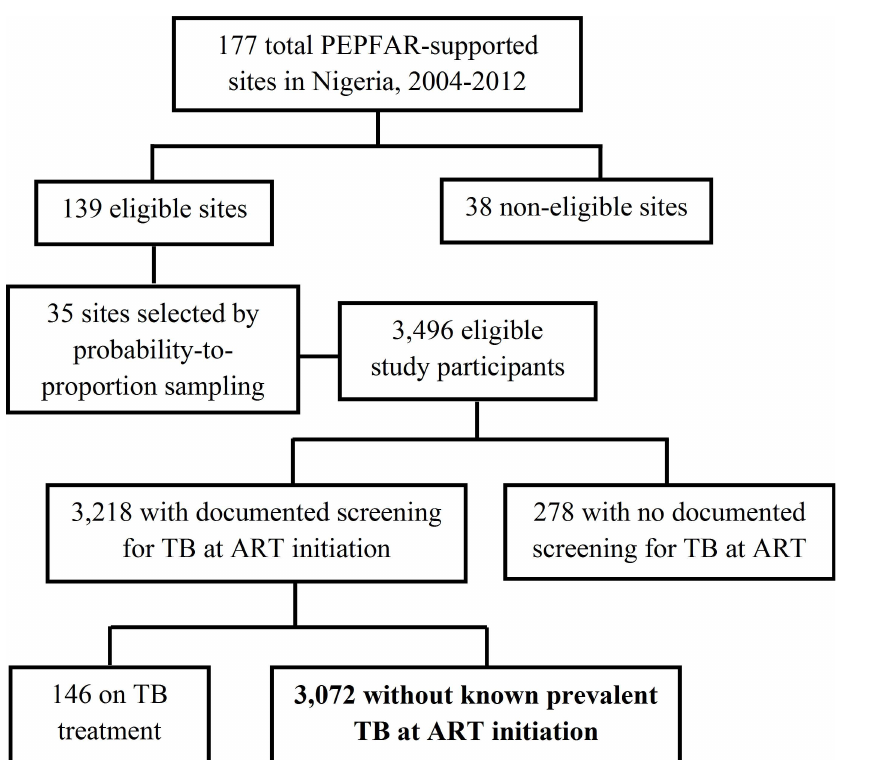
Fig 1. Participant Flow Diagram (Unweighted Study Sample